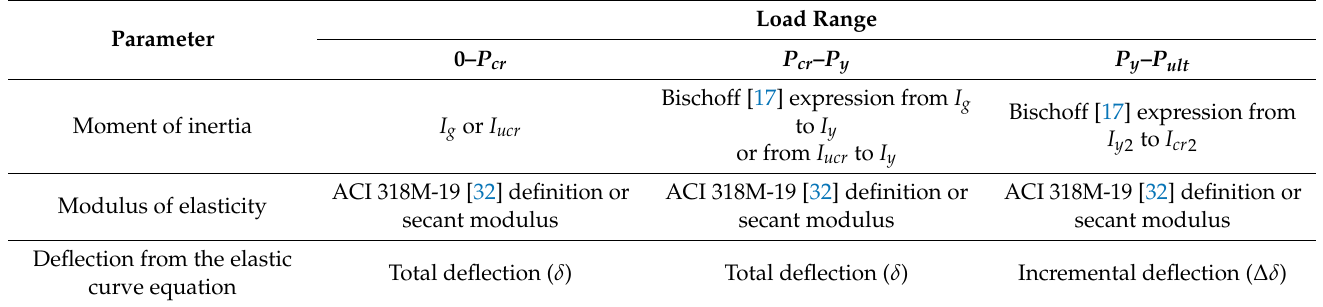
Figure 11. Method for estimating deflections of hybrid FRP-steel RC beams. Table 4. Method for estimating the deflections of hybrid FRP-steel RC